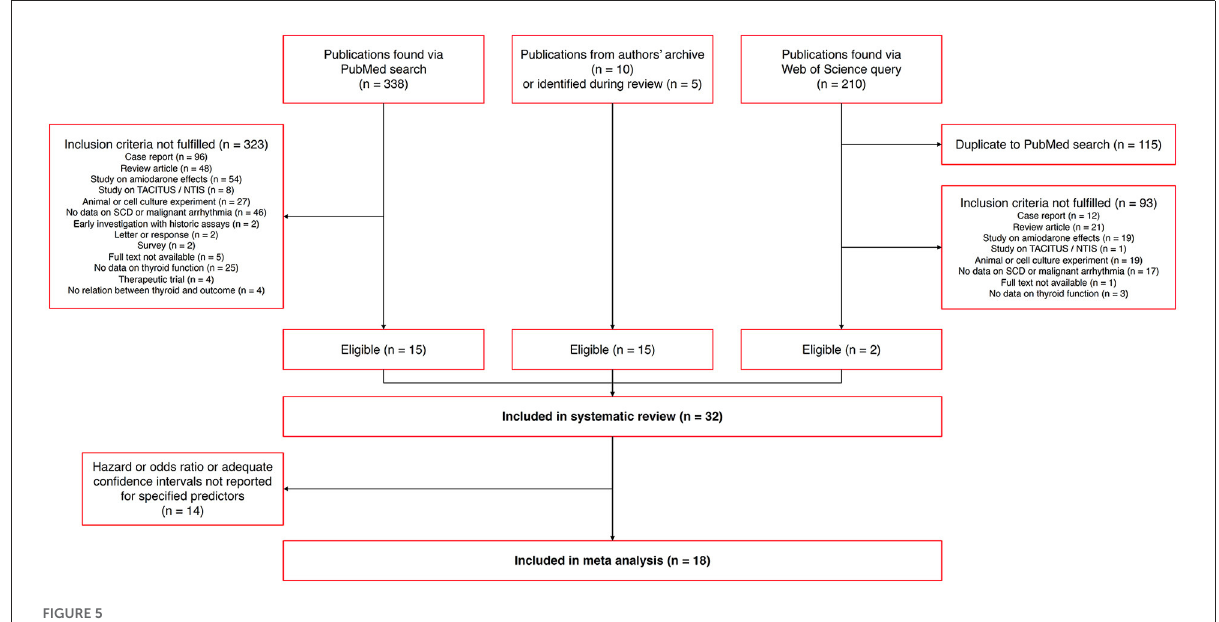
FIGURE5 Flowchart of identified, eligible and included